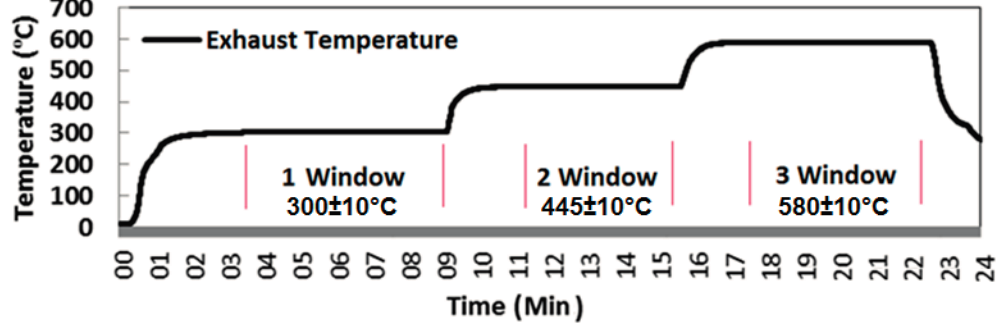
Figure 4. Exhaust Temperature profile for illustration of engine test windows.